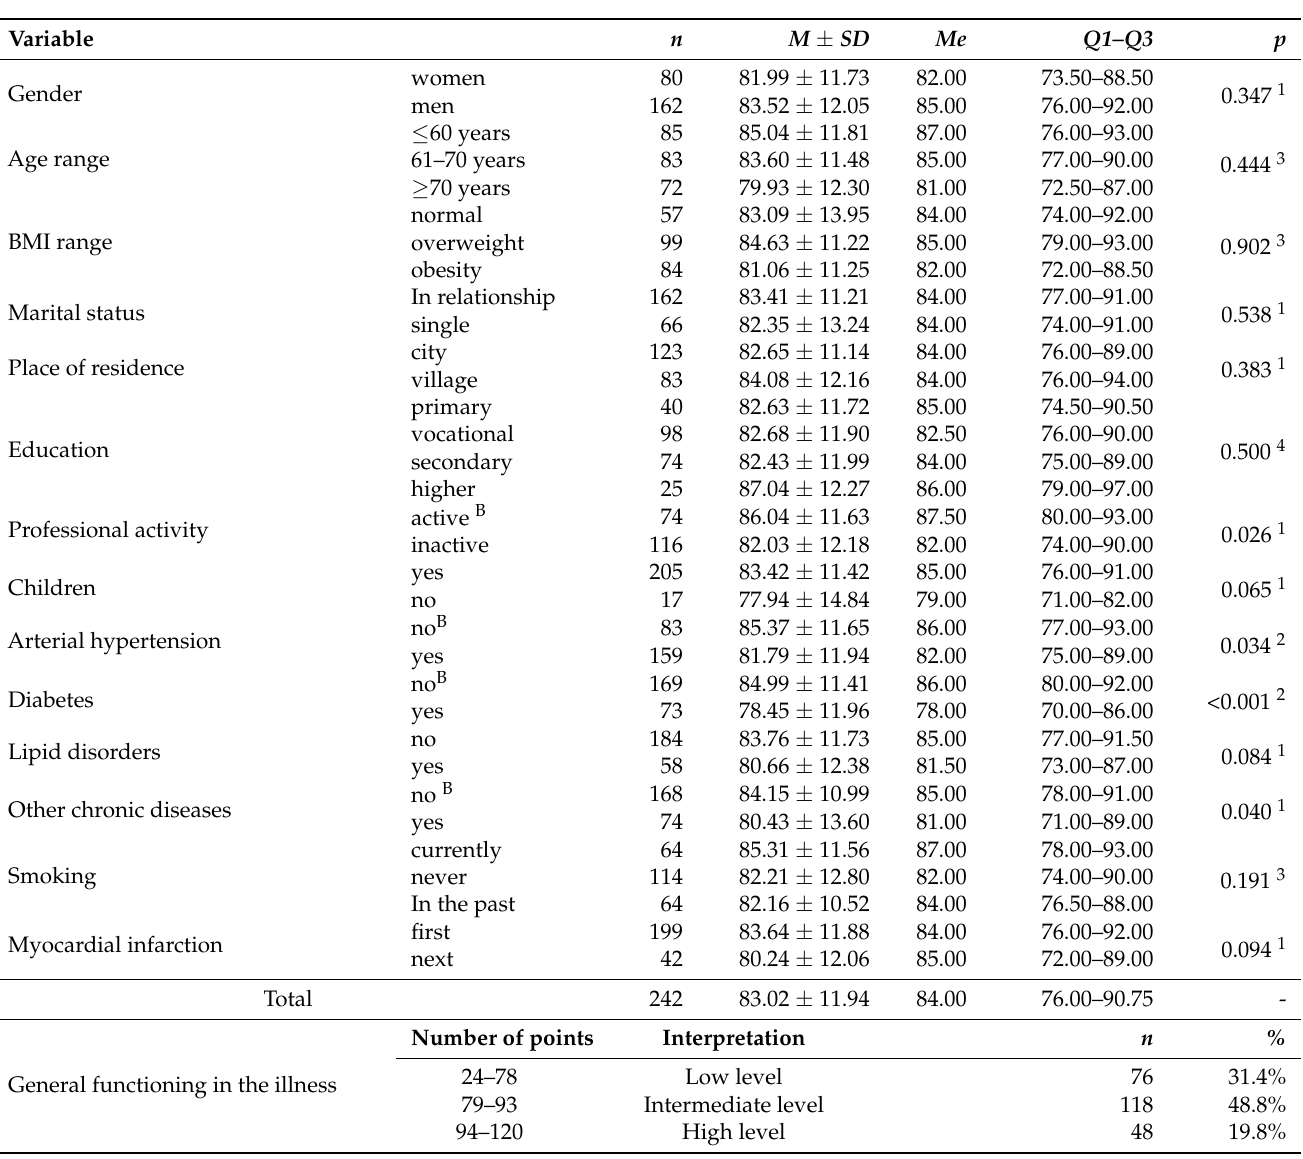
Table 3. The socio-demographic and clinical variables on the Functioning in Chronic Illness Scale in MI